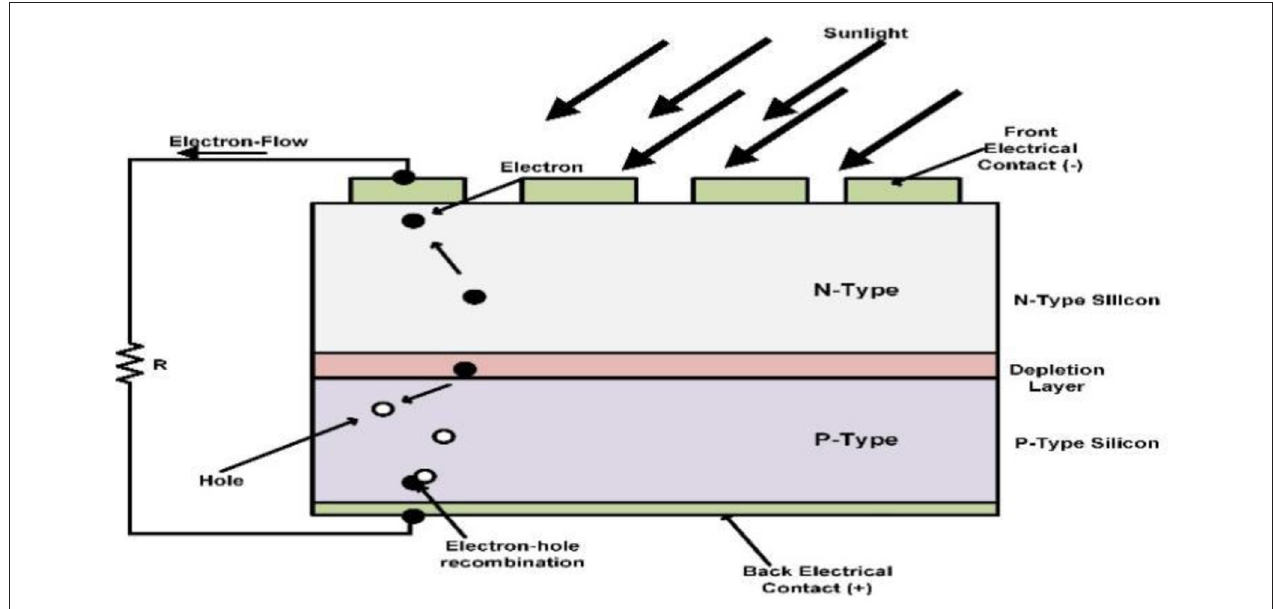
FIGURE 1 | Structure of a photovoltaic cell [9].